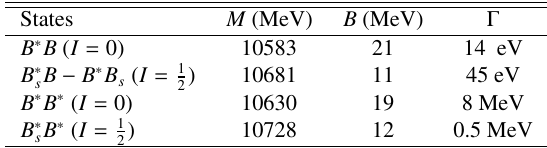
Table 2. States of J P = 1 + obtained from the di ff erent sectors considered. The binding energy B is referred to the closest threshold and M and Γ stand for the mass and width of the predicted states,